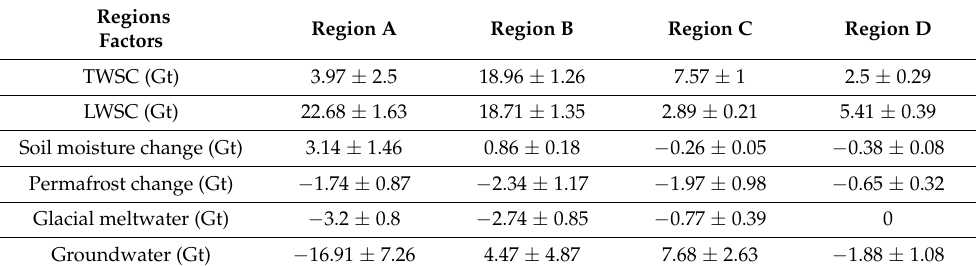
Table 2. Changes and uncertainty of different factors in four regions during 2005–2013.